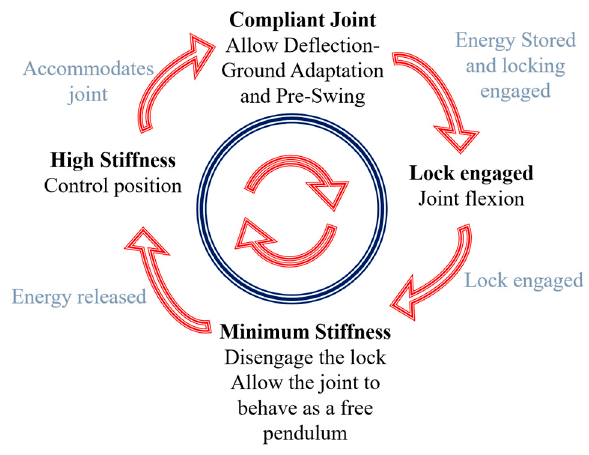
Figure 11. Schematics of the state machine applied to emulate the knee swing.